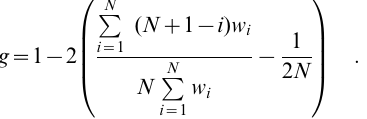
areas mark times of war, dashed lines represent linear fits omitting the transient first 120 days. The slopes of these lines are 4.3, 3.5,